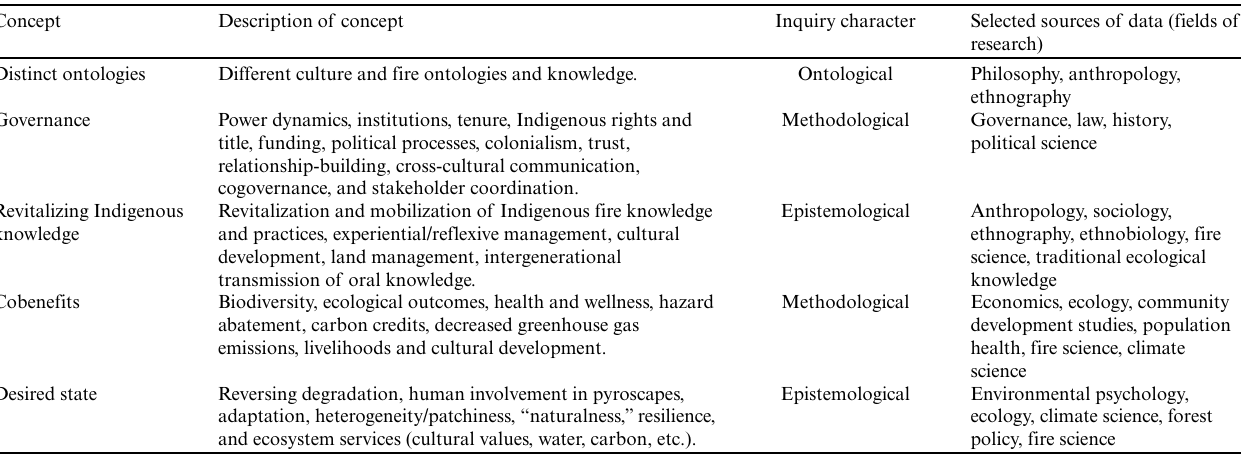
Table 2 . Conceptual framework analysis: deconstructing and categorizing the concepts (adapted from Jabareen 2009).